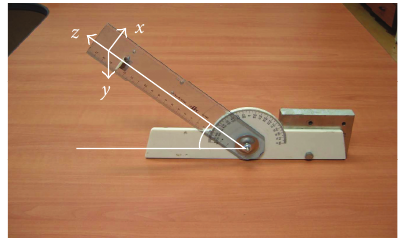
Figure 8: The equipment used for